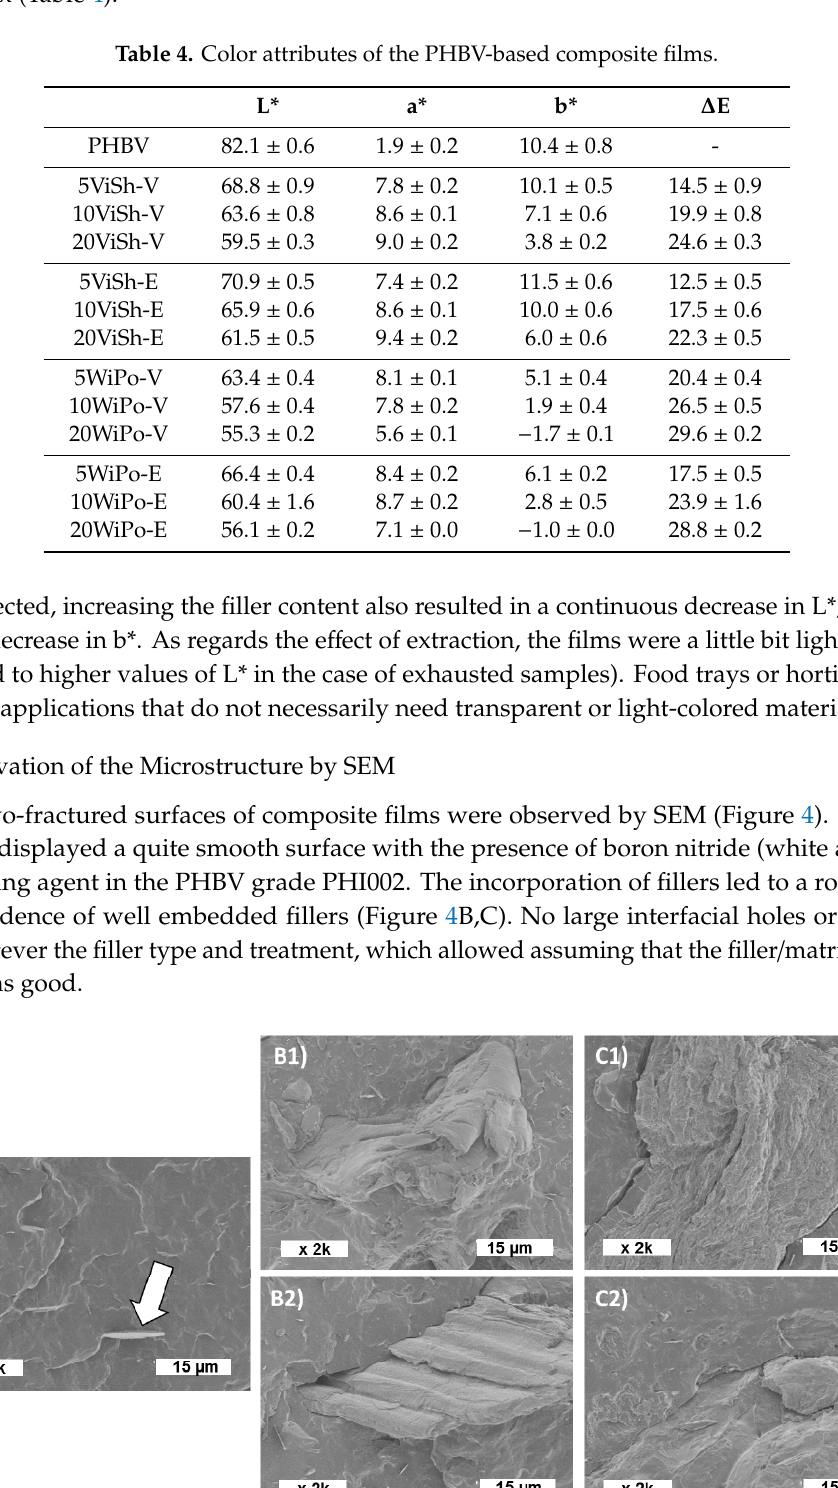
Table 4. Color attributes of the PHBV-based composite films.